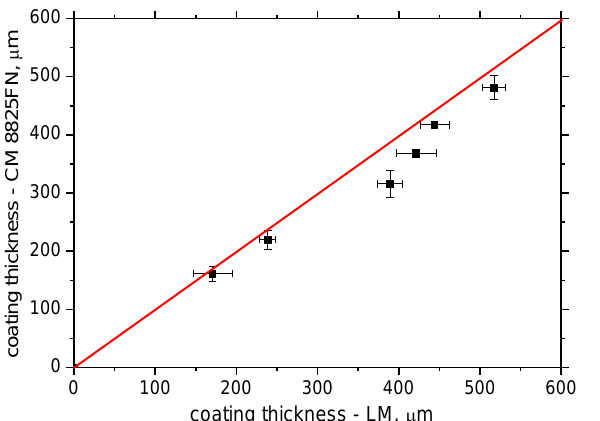
Figure 4. Correlation between coating thickness obtained from light microscopy (LM) and measured by the use of CM- 8825FN gauge.